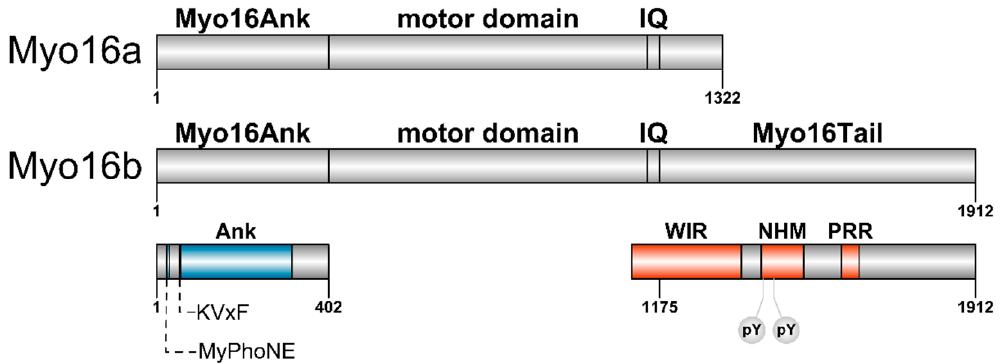
Figure 1. Domain structure of unconventional Myo16 isoforms. The number of amino acids corresponds to the rat Myo16 protein (accession number: Q9ERC1). Myo16a (1322 aa, 148.75 kDa) is composed of an N-terminal ankyrin domain (Myo16Ank) possessing a conserved myosin phosphatase N-terminal element (MyPhoNE), a KVxF sequence motif (protein phosphatase type 1 catalytic subunit (PP1c) binding motif) and eight ankyrin repeats (Ank). Myo16Ank is followed by the motor domain, a single IQ motif and a short C terminal region. The domain organization of the N-terminus of Myo16b (1912 aa, 210.56 kDa) is identical to that of Myo16a. Myo16b, following the IQ motif, has a longer C-terminal tail extension (Myo16Tail) including a WAVE1 interacting region (WIR), a neuronal tyrosine-phosphorylated adaptor for phosphoinositide 3-kinase (NYAP) homology motif (NHM) and proline-rich regions (PRR). The phosphotyrosines (Y 1416 and Y 1441 ) in the NHM motif are indicated (pY).